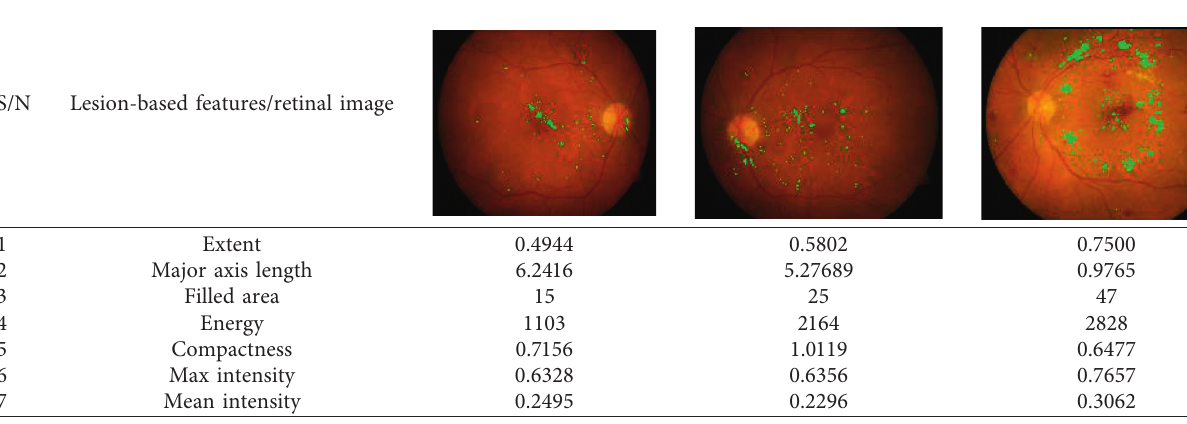
Table 3: Lesion-based features extracted from segmented exudates.